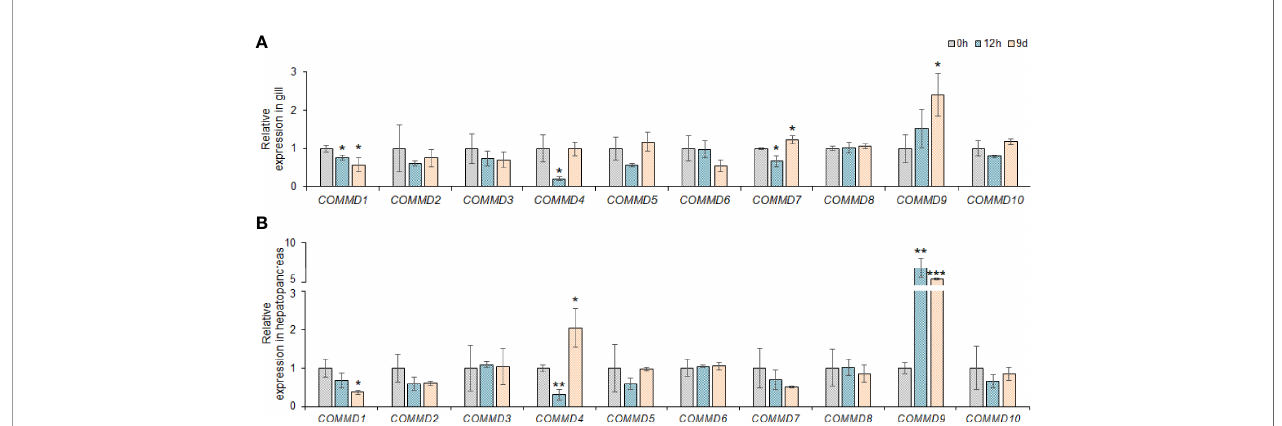
FIGURE 6 | Relative expression of COMMD genes in M. lateralis gill and hepatopancreas under copper ion stress. (A) Relative expression of MLCOMMDs in gill under copper ion stress. (B) Relative expression of MLCOMMDs in hepatopancreas under copper ion stress. The fold changes compared with the control group for each test point are shown as a bar chart (signi fi cance: ***P < 0.001; **P < 0.01; *P < 0.05). The gray, light blue and light orange boxes respectively indicate 0 h, 9h and 9d under copper ion